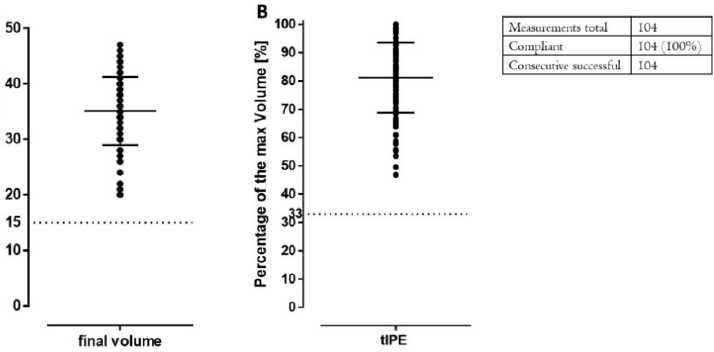
Figure 8. Extracellular remnant DNA. Remaining remnant extracellular DNA potentially contami- nating tIPE, was measured in the centrifugation supernatant. Removal was successful in 72 out of 86 productions. The dashed line marks the limit for product release.